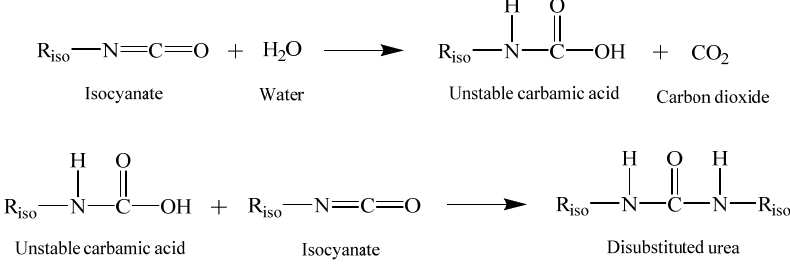
Scheme 2. Reaction scheme of the isocyanate with water [10].